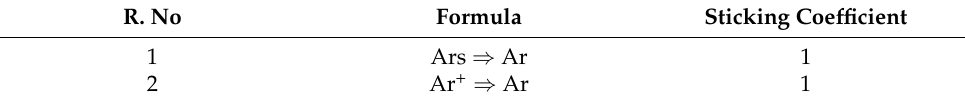
Table 2. Surface